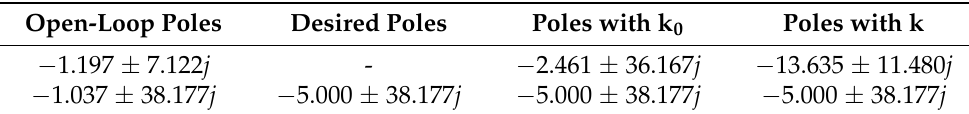
Table 2. Test case 1: open-loop and closed-loop poles.